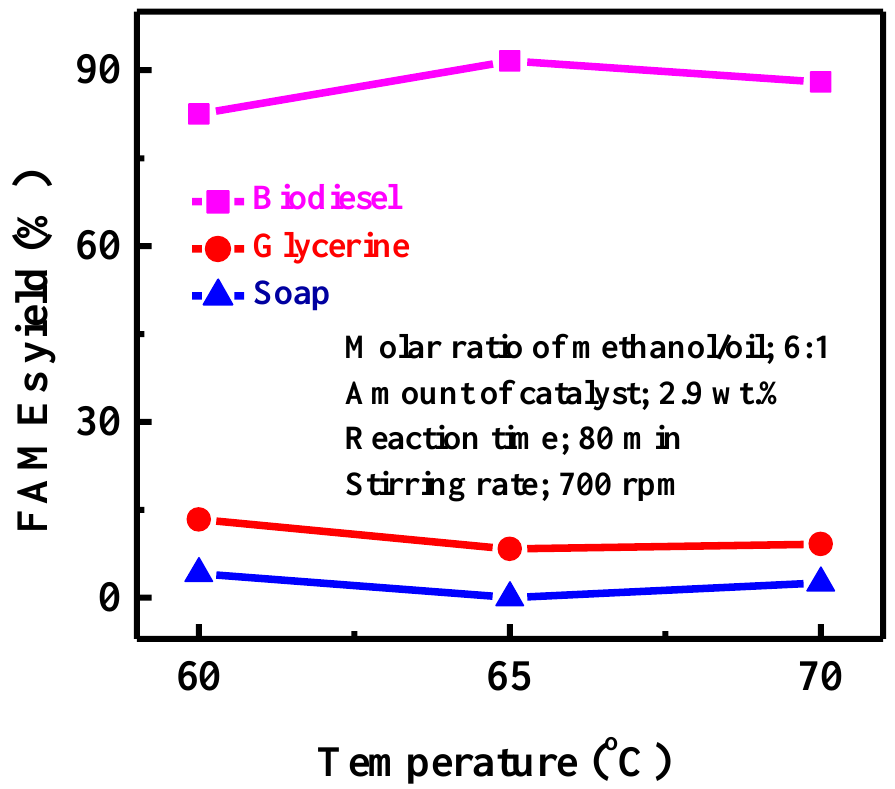
Figure 4. E ff ect of temperature on RTOB Figure 4. Effect of temperature on RTOB yield.